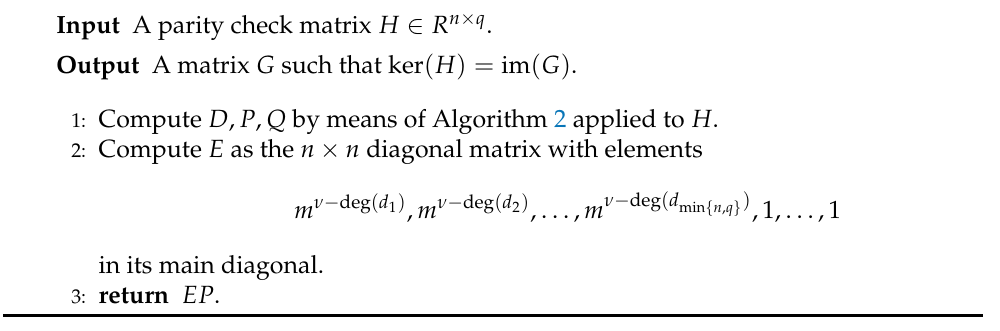
Algorithm 3: Generating matrix computation from a parity check